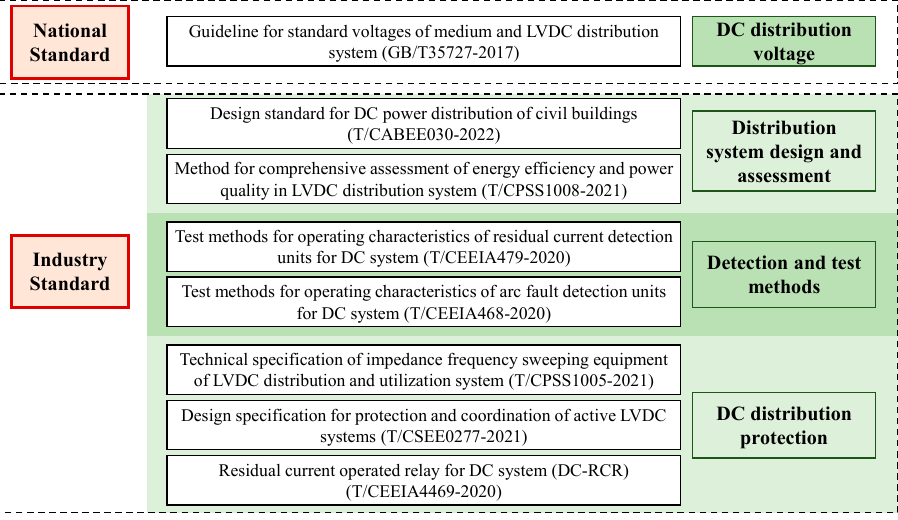
Figure 1. New standards for LVDC technology in the past five years.